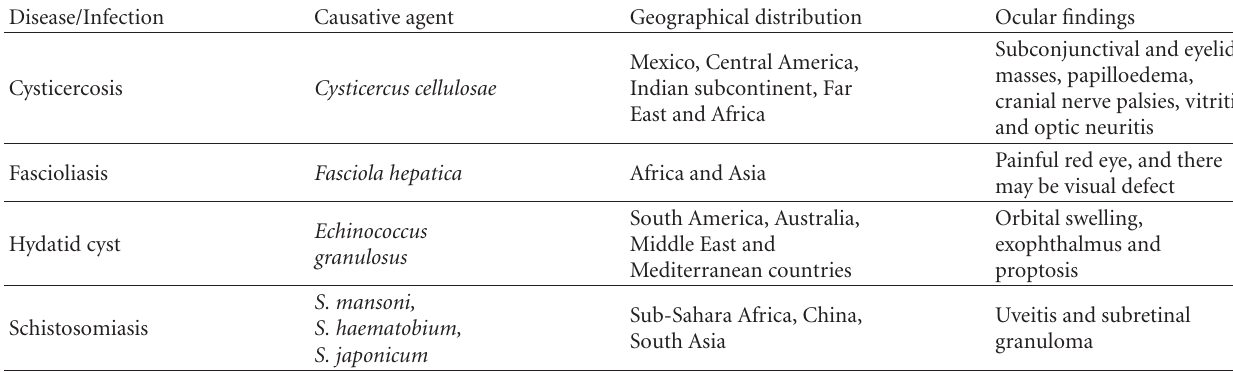
Table 5: Ocular parasitosis caused by flat worms ( geographical distribution & ocular findings ).